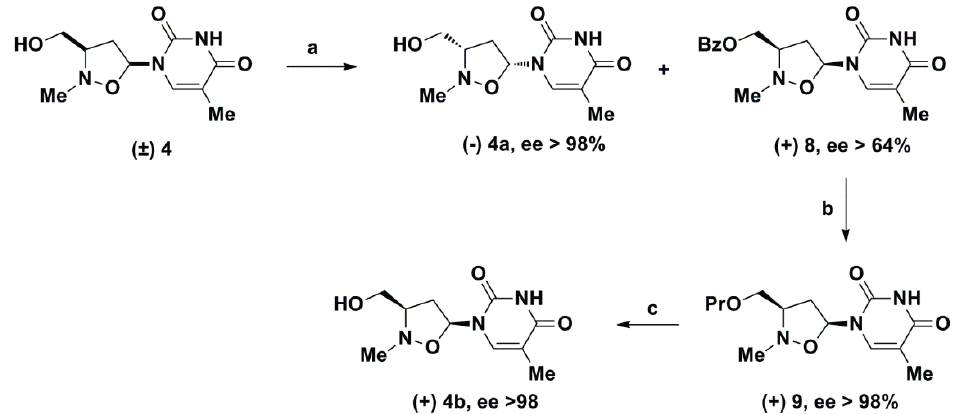
Reagents and conditions : (a) Lipozyme, 1,4-dioxane, vinyl benzoate, 45 °C; (b) NH